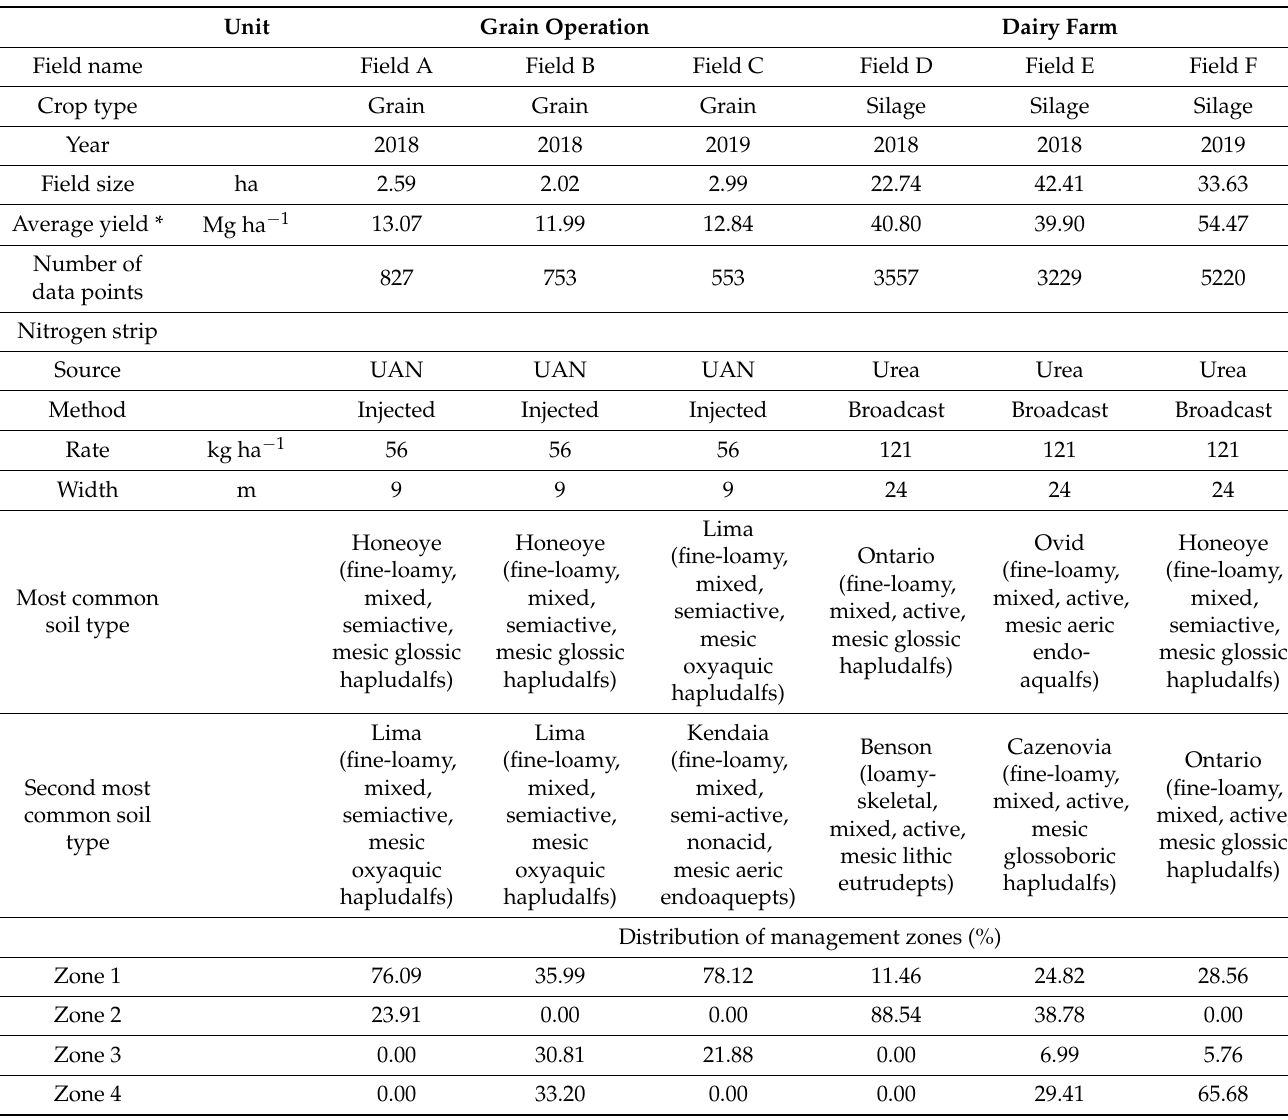
Table 1. Crop type, year, field size, average yield production, number of data points from the yield monitor system, information about nitrogen strips, soil types, and distribution of management zones, delineated as suggested by Kharel et al. [15] for three fields on a grain operation (harvested for corn grain) and three on a dairy farm (harvested for corn silage). Unit Grain Operation Dairy